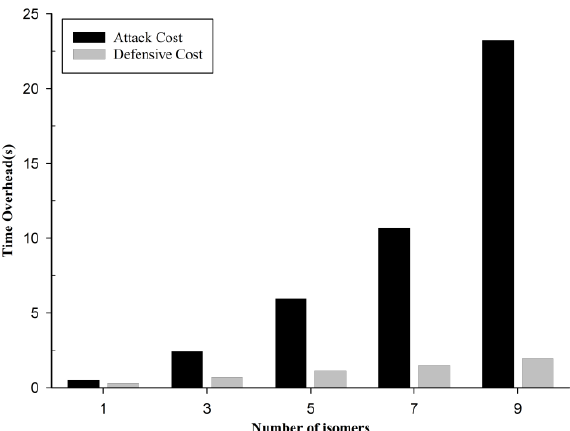
Figure 18. Effect of the number of isomers.